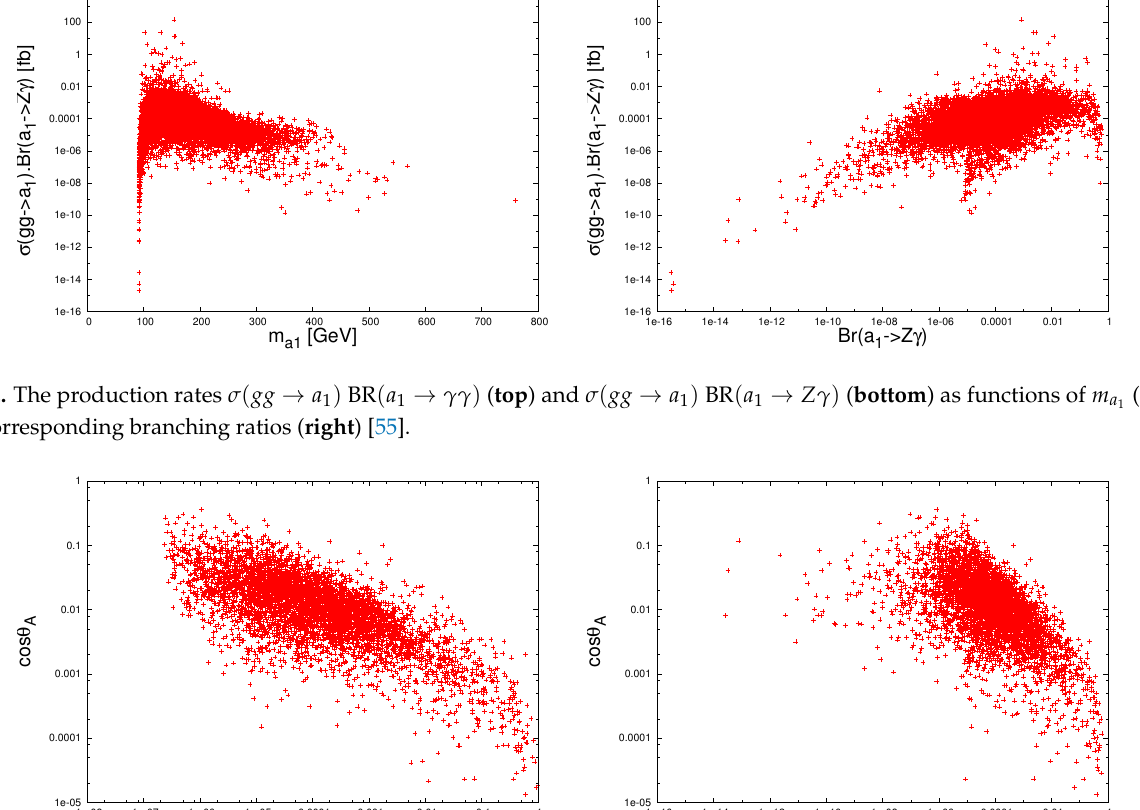
Figure 3. The correlations between the mixing angle cos θ A and the branching ratios BR ( a 1 → γγ ) ( left ) and BR ( a 1 → Z γ ) ( right ) [55]. 4. Light Pseudoscalar Higgs Boson Production with a Single Bottom-Quark at the LHC The a 1 production in association with a single bottom-quark at hadron colliders can occur at the tree-level through either the process gb → ba 1 or the process g ¯ b → ¯ ba 1 . Since the production cross sections for the process pp → ba 1 at the LHC and its charge conjugate pp → a 1 ¯ b are alike, we only consider here the production process pp → a 1 b . This process has an advantage that the existence of the bottom-quark with a high transverse momentum in the final state can be tagged, allowing the rejection of light jets. Furthermore, this process can be significantly enhanced at large values of tan β . Since the a 1 production through the process pp → a 1 b followed by the a → b ¯ b decay is plagued by large backgrounds, we only discuss in this section the LHC discovery potential of a light pseudoscalar through the process pp → ba 1 followed by the a 1 → τ + τ −